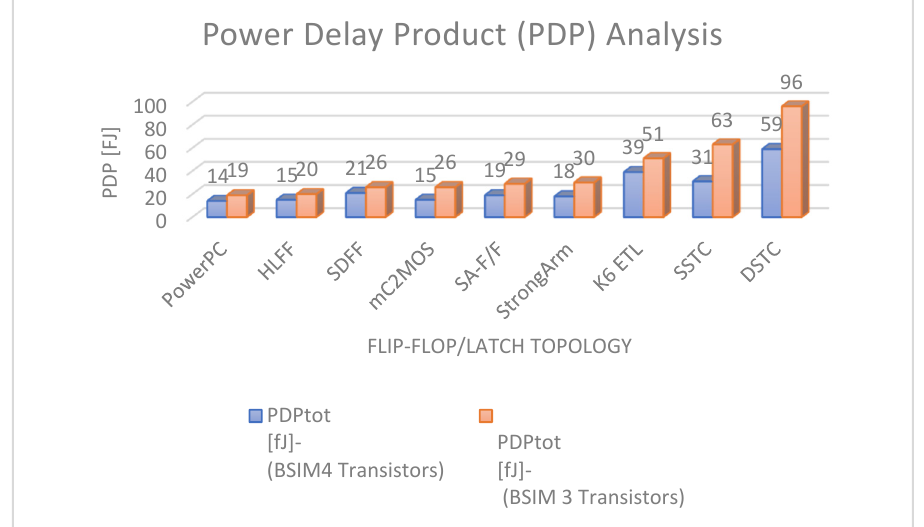
Figure 21. Power delay product (PDP).